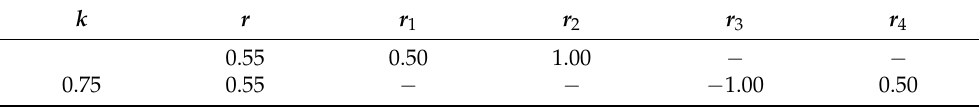
Table 5. Coefficients